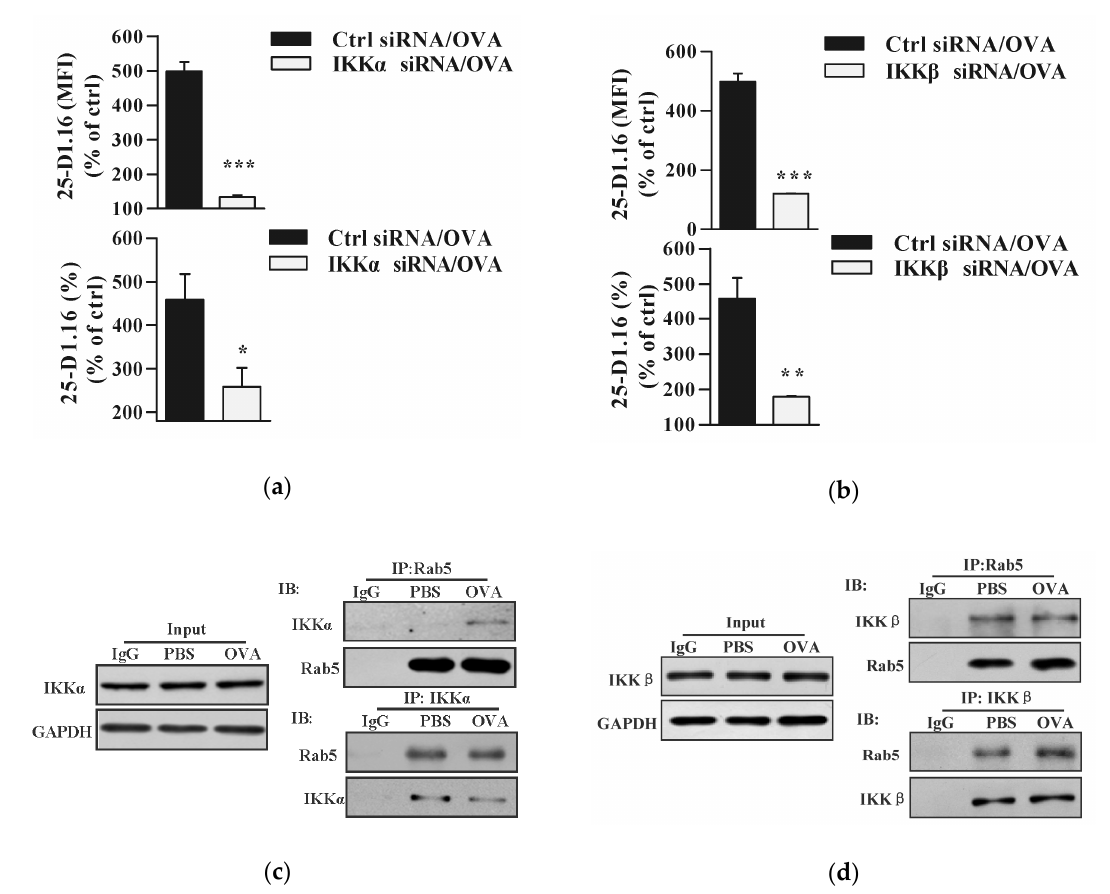
Figure 3. Both IKK α and IKK β phosphorylation augment endotoxin-containing pathogen-derived cross-presentation in bone marrow precursor cells. ( a , b ) Murine IKK α / IKK β deficient or control BMPC was incubated with endotoxin-containing pathogen ovalbumin (50 µ g / mL) and cross-presented OVA was assessed by flow cytometric analyses. ( c , d ) Murine BMPC was incubated with endotoxin-containing pathogen ovalbumin (50 µ g / mL) and the interaction of IKK α -Rab5 ( c ) or IKK β -Rab5 ( d ) was investigated by Co-IP with Rab5, IKK α or IKK β antibody, respectively. Isotype IgG was used as negative control. Whole cellular protein was used as input control. Data are presented as the mean ± SEM, * p < 0.05, ** p < 0.01, *** p < 0.001, Student t -test. One representative from three independent experiments is shown. OVA: endotoxin-containing pathogen ovalbumin.